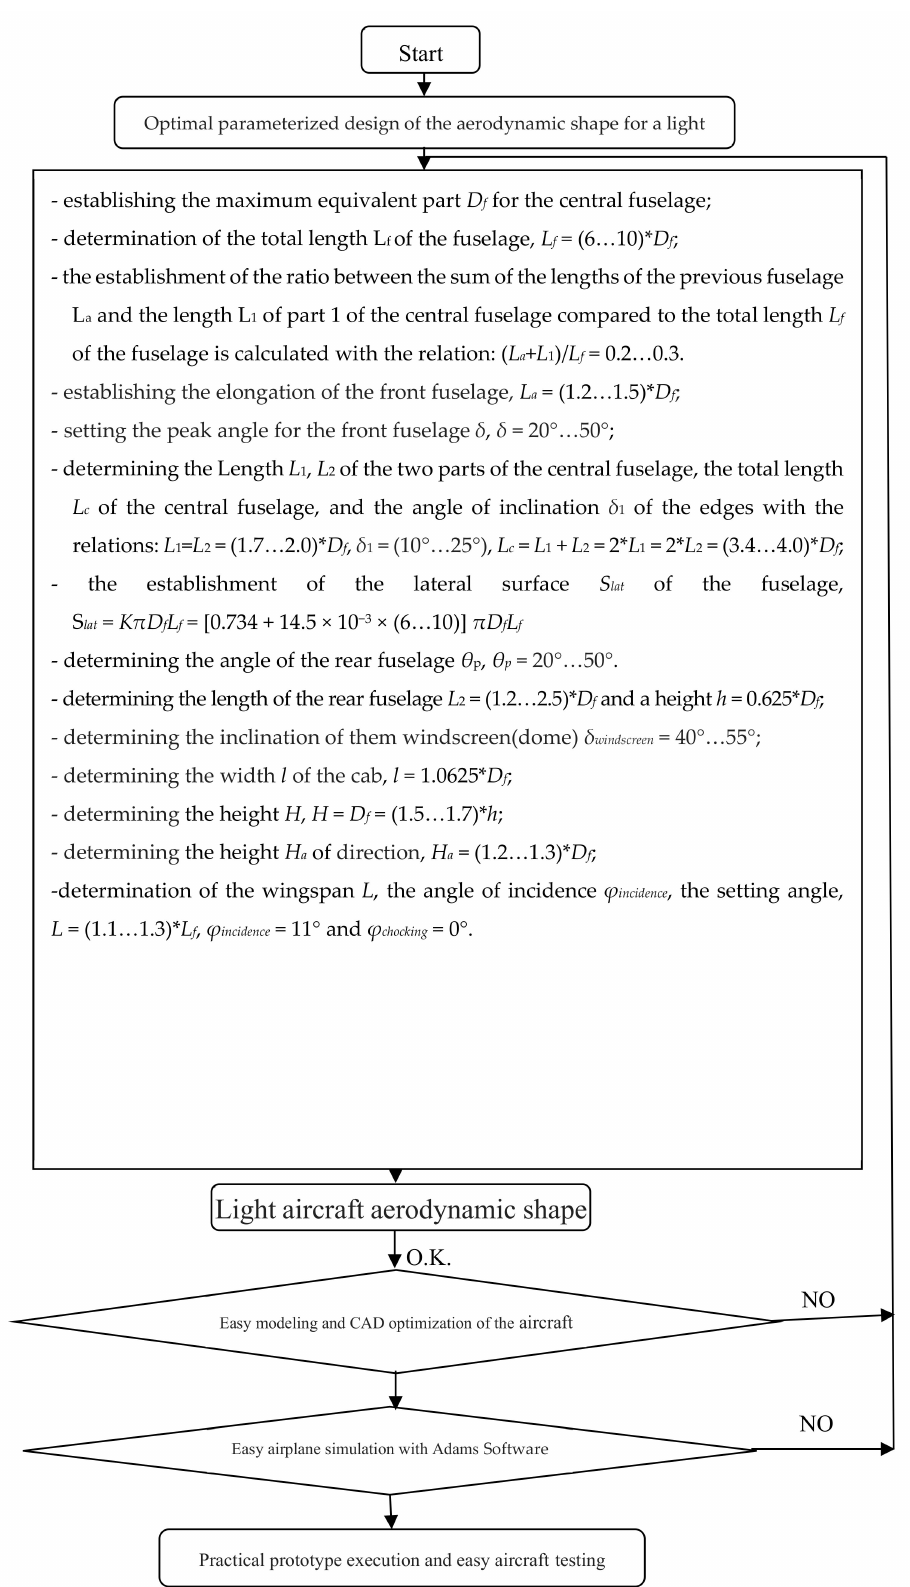
Figure 8. The logic diagram of optimal design method of light